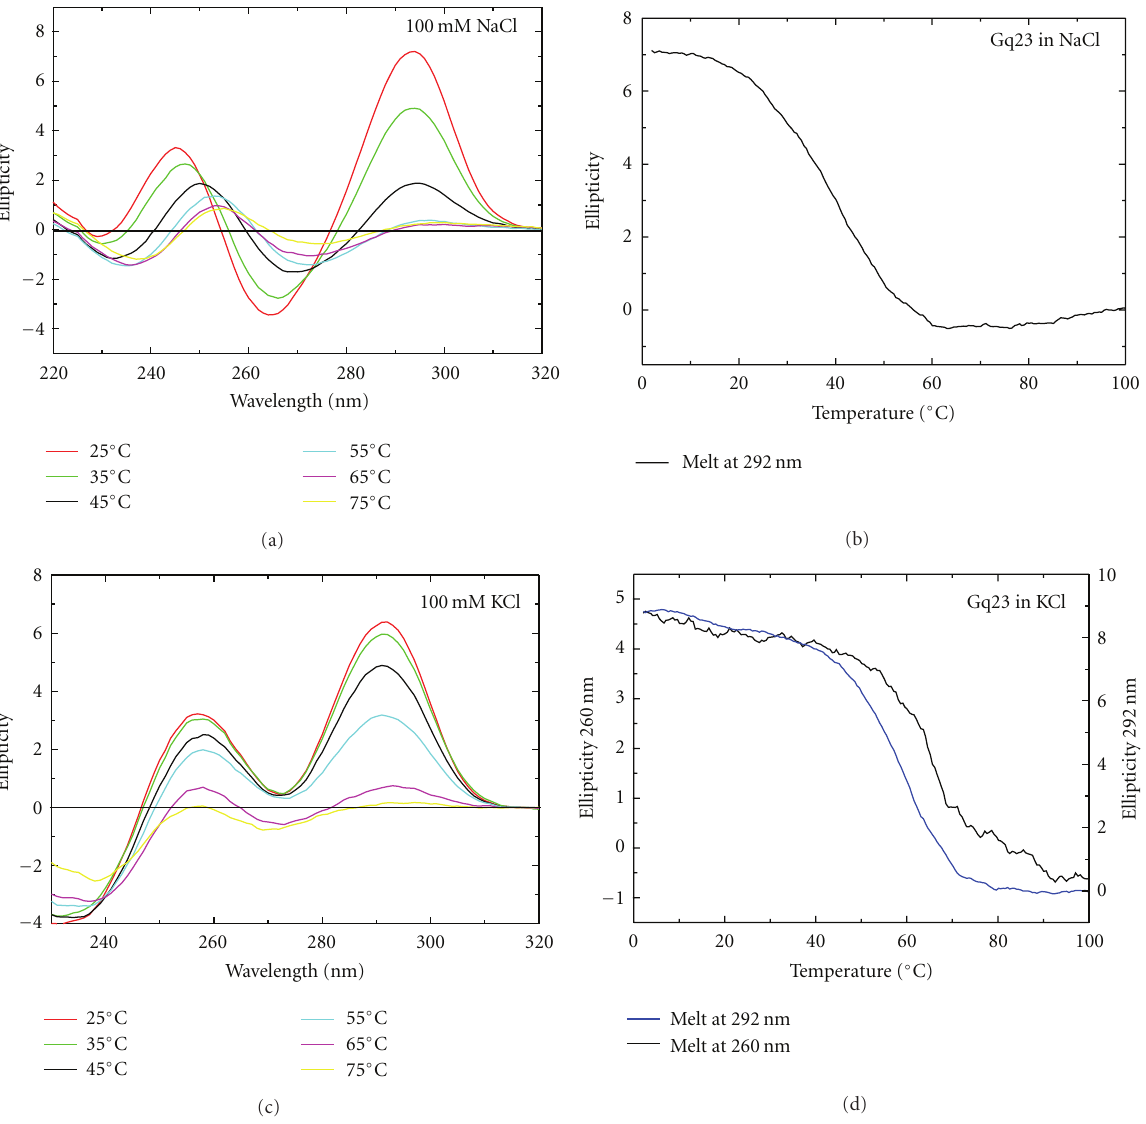
Figure 1: The e ff ect of monovalent cations on Gq23 structure and thermal stability. (a) CD spectra at varying temperatures of Gq23 in a bu ff er containing 100mMNaCl. (b) Gq23 melt at 292nm in 100mMNaCl. (c) Spectra of Gq23 in a bu ff er containing 100mMKCl recorded at varying temperatures from 25 ◦ C to 75 ◦ C. (d) Gq23 melt at both 292nm and 260nm since both peaks were seen at both wavelengths throughout the temperature